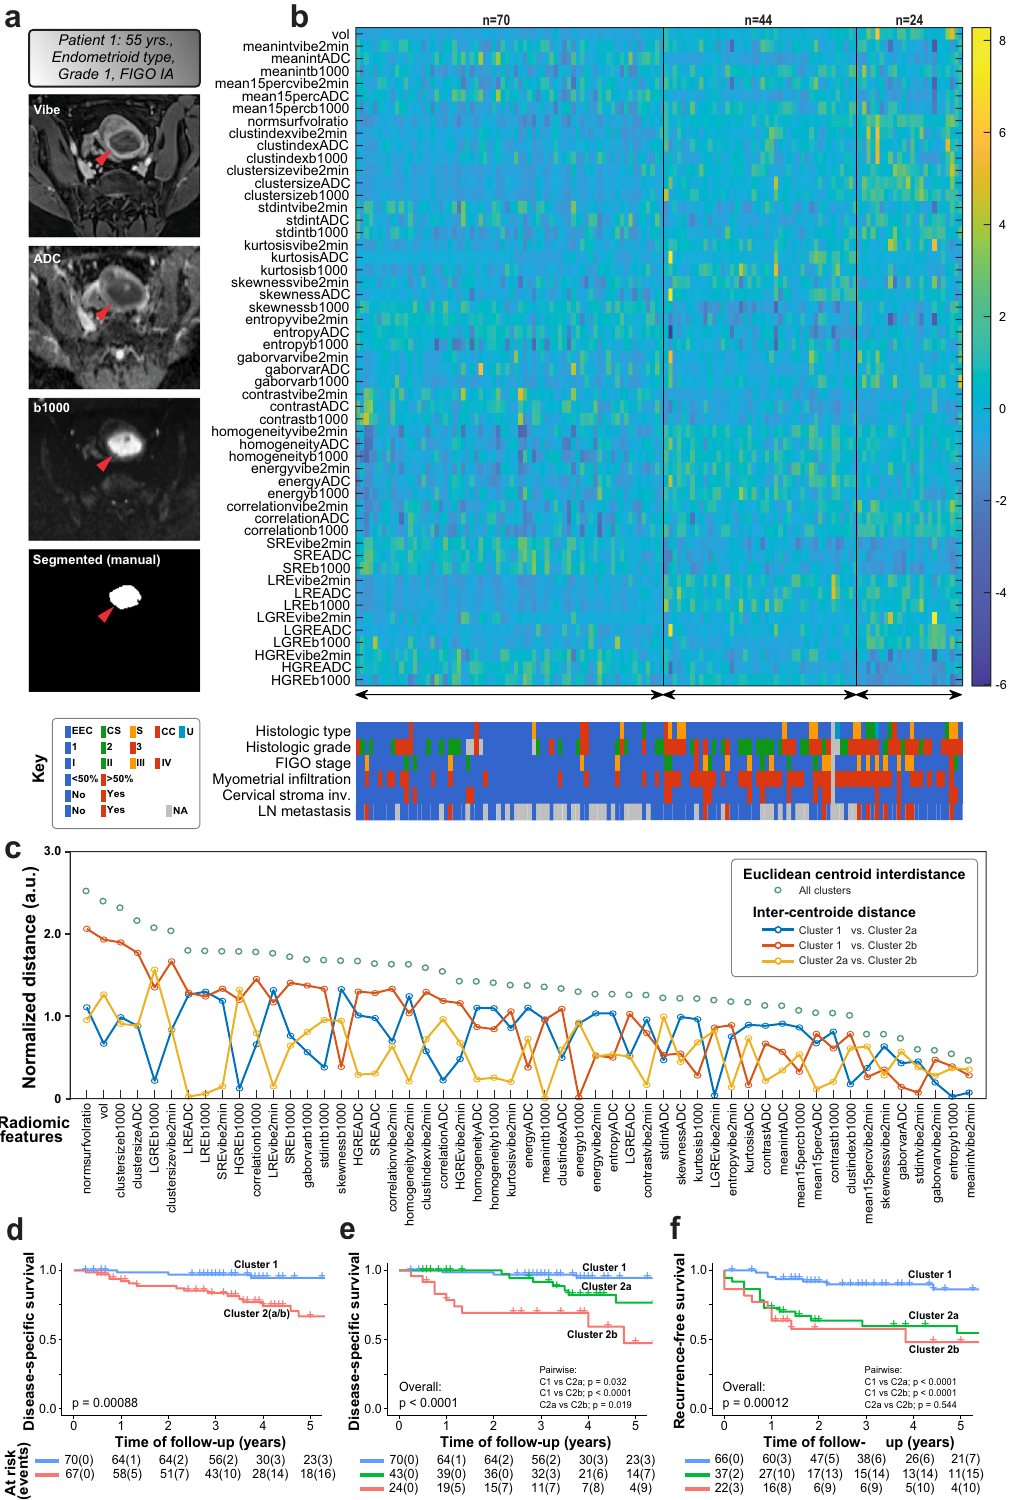
often presented high-risk clinico-pathological features including deep myometrial in fi ltration (>50%; p = 0.001), lymph node metastases ( p = 0.020), high-grade histology ( p = 0.001), non- endometrioid subtype ( p = 0.014), and advanced FIGO stages ( p = 0.006) (Fig. 2b, bottom panel; Table 1). Cluster 2b tumors were of higher grade ( p = 0.050) and were more likely to be of non-endometrioid type ( p = 0.050) compared to tumors of